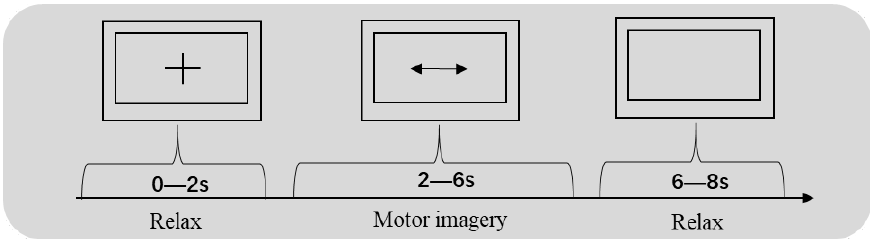
Figure 1. Schematic diagram of the experiment and the timing during a session using the Brain– Computer Interface (BCI) Competition IV dataset 1.